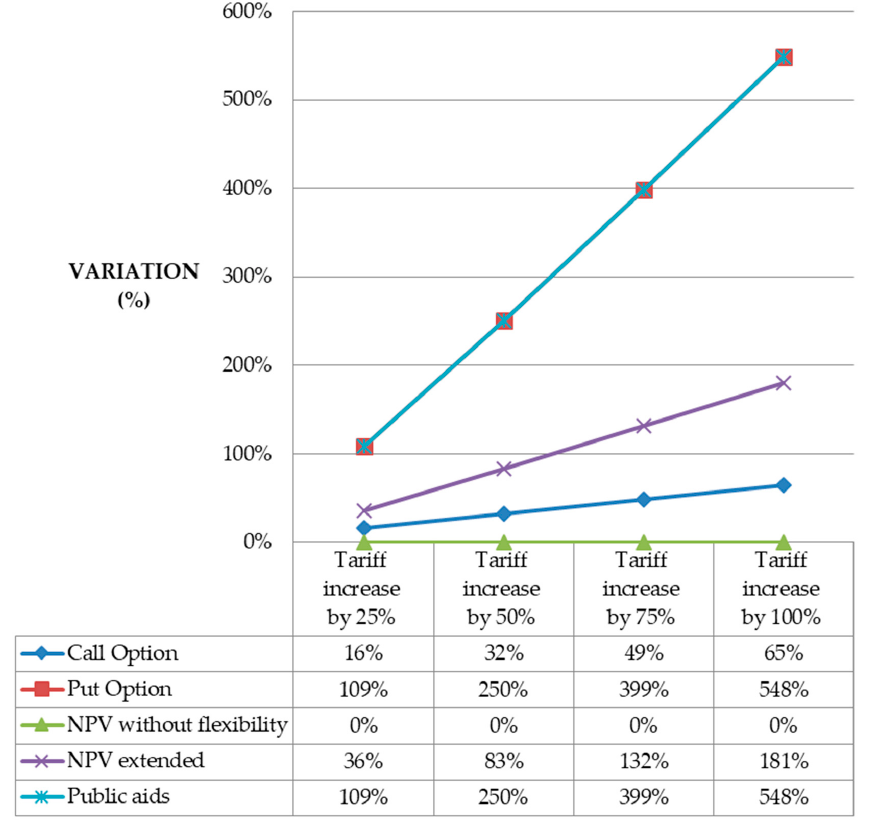
Figure 3. E ff ects of increasing the regulated tari ff (source: own elaboration). Energies 2020 , 13 , x FOR PEER REVIEW Figure 3. Effects of increasing the regulated tariff (source: own elaboration).